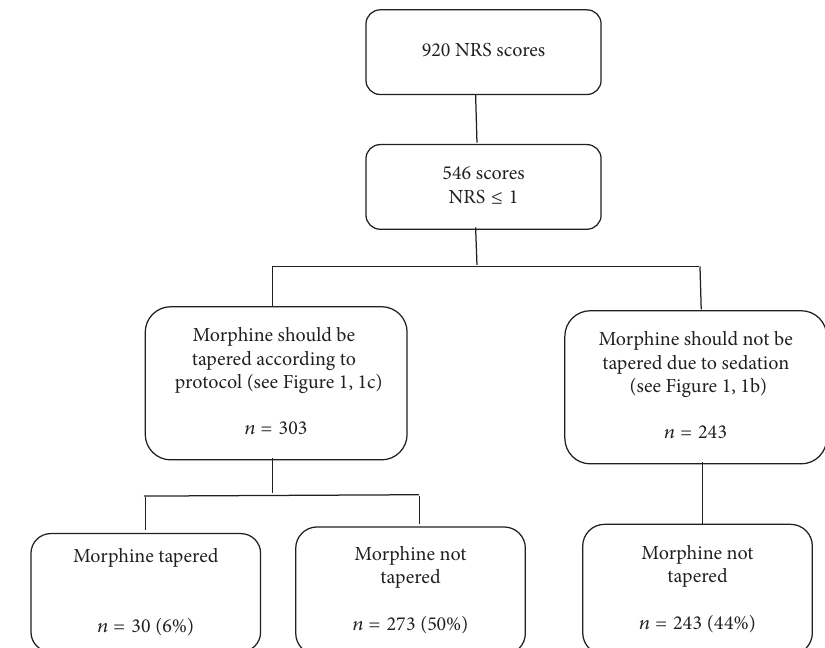
Figure 3: Actions upon pain scores with NRS ≤ 1. NRS: numeric rating scale.